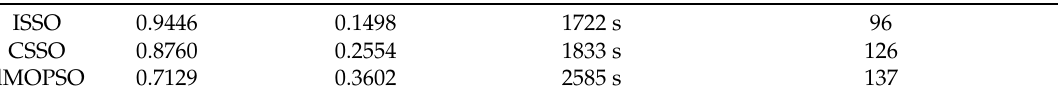
Table 5. The Matlab/simulink evaluate results of different algorithms for Jinpu line No.1 in Dalian scenario.